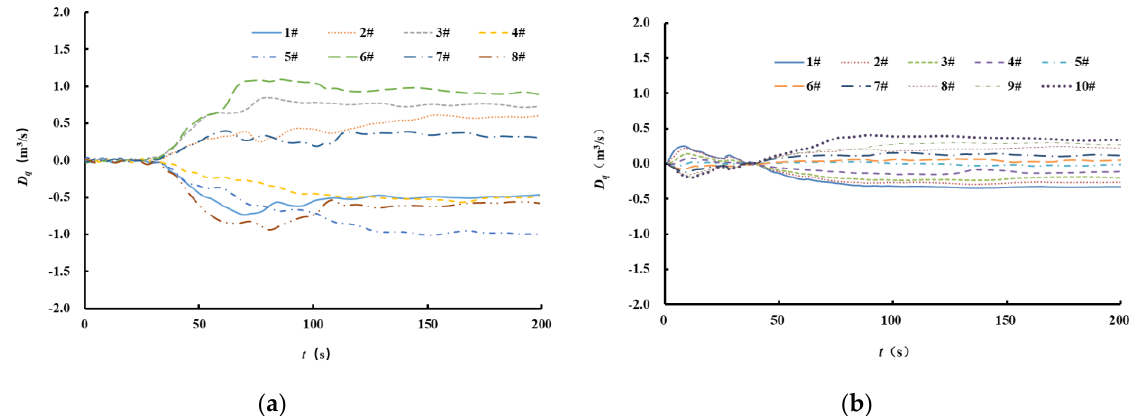
Figure 16. The D q process of each branch outlet flow in the filling–emptying system under the condition of a 150 m lifting height: ( a ) the diagram of the equal inertial pipeline and ( b ) the longitudinal culvert.